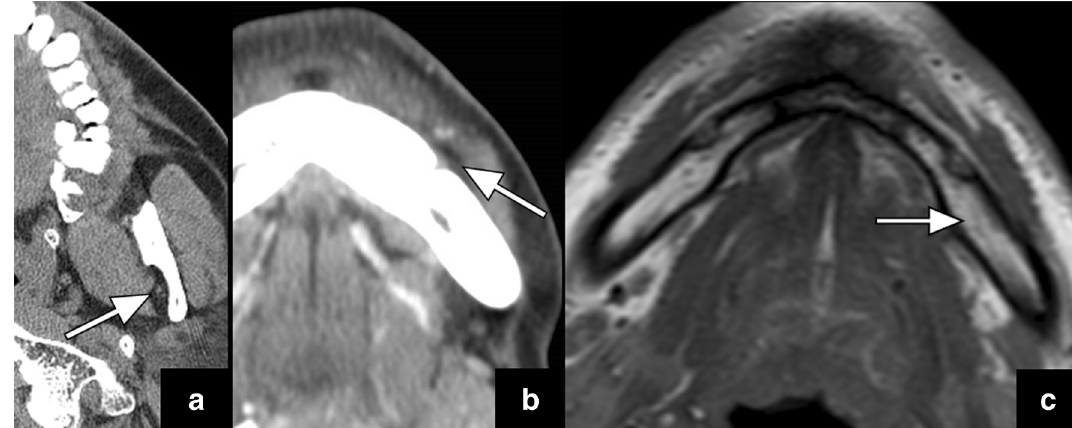
Fig. 4 Axial ( a and b ) CT images demonstrate a normal prominent fat pad at the mandibular foramen ( arrow in a ) as well as a markedly smaller fat pad anterior to the mental foramen ( arrow in b ). Axial T1